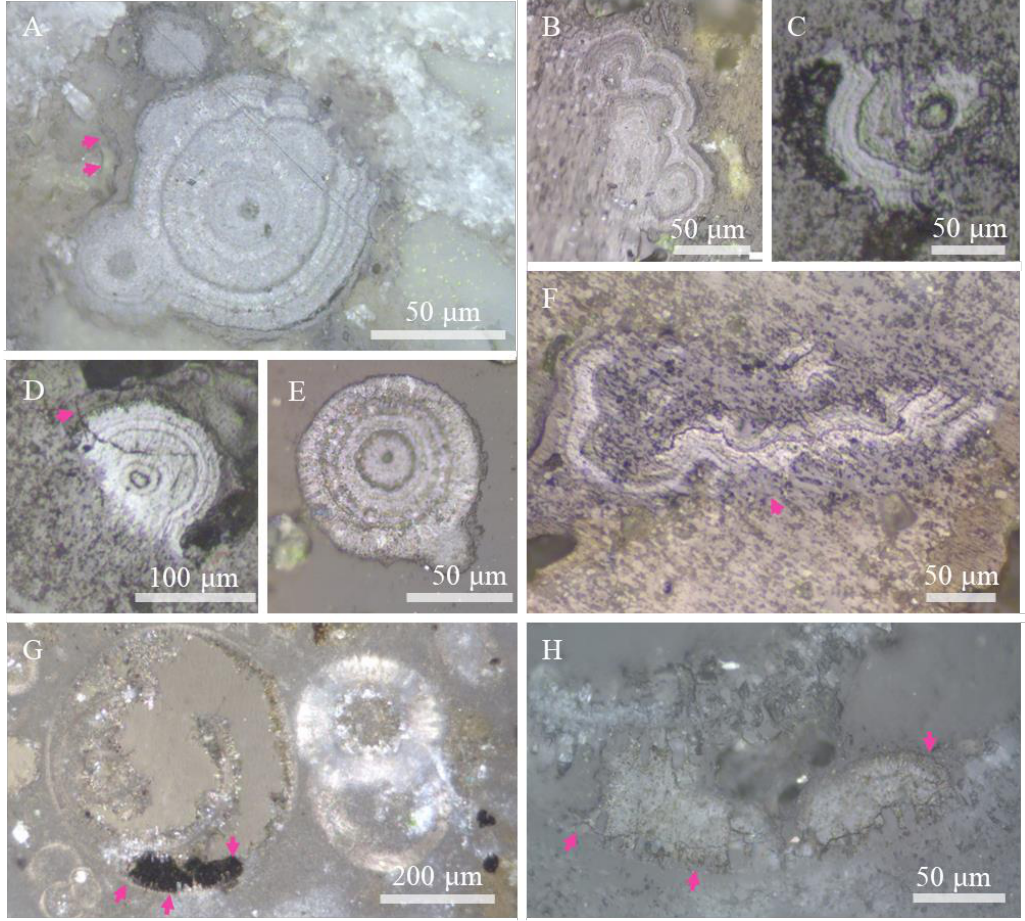
Figure 3. Examples of di ff erent Mn mineral textures captured in thin polished section photomicrographs. Concentric growth of nodules ( A , E ), botryoidal pattern of laminated ( B , F ), and sub-spherical shape ( C , D ). Pink arrows indicate that manganic minerals around the micro-nodules were of lower reflectivity compared to the higher reflectivity with the nodules. ( G , H ) Some of the low-reflectivity manganic minerals growing in a fossil.